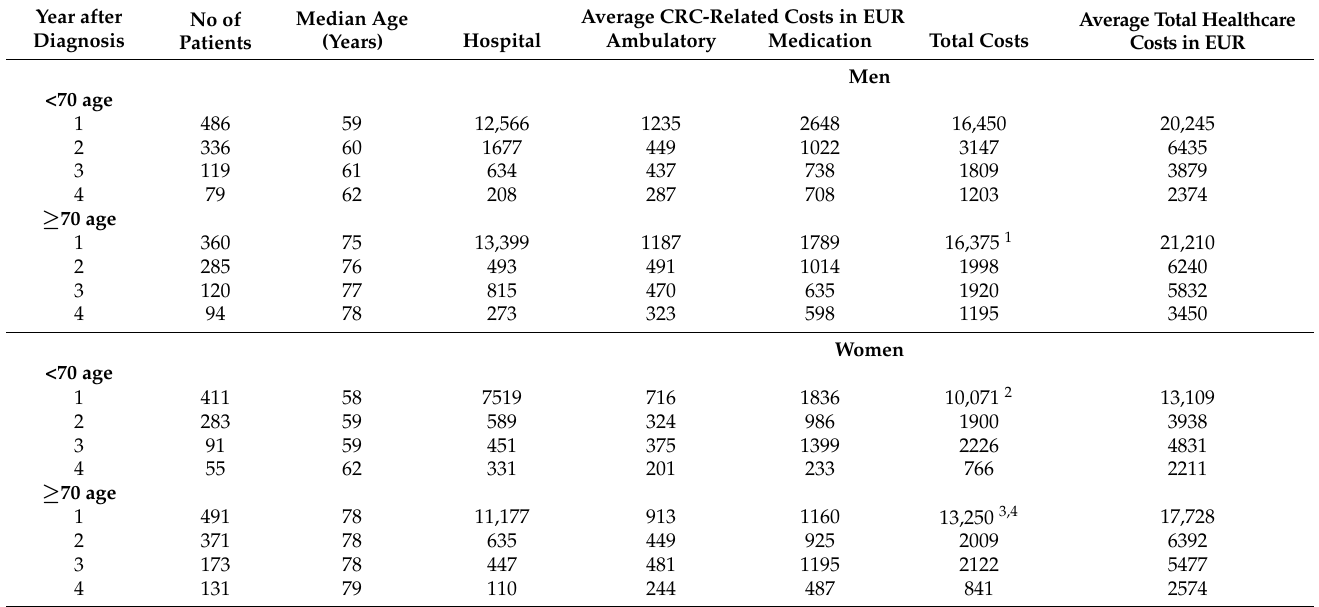
Table 1. Inpatient, outpatient and medication costs, as well as total healthcare costs 1–5 years after diagnosis, stratified by sex and age.